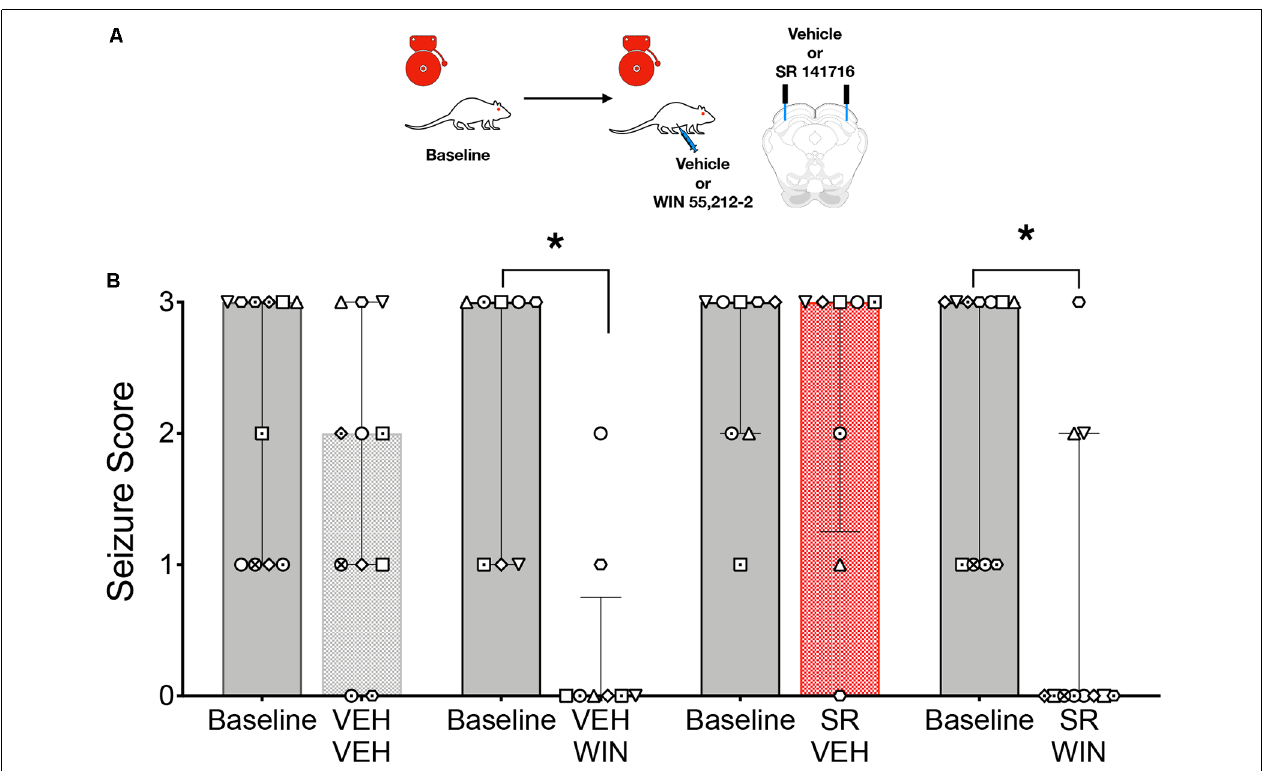
FIGURE 3 | Activation of collicular CB1/2 receptors is sufficient, but not necessary to account for the anticonvulsant effect of systemic WIN 55,212-2 (WIN) in GEPRs. (A) Schematic of the testing scheme; animals were tested with a baseline test session before each of the four test conditions. Animals received either vehicle (VEH) or SR 141716 (SR) infusion into the DLSC followed by VEH or WIN (2 mg/kg, i.p.). (B) AGS score as a function of drug treatments. WIN administration significantly reduced AGS severity as compared to the pre-administration baseline. SR administration was without effect on audiogenic seizures (AGSs) but failed to reverse the anticonvulsant action of WIN. Bars show median and interquartile range, symbols show individual subjects. * p < 0.05, according to Friedman test followed by Dunn’s post hoc